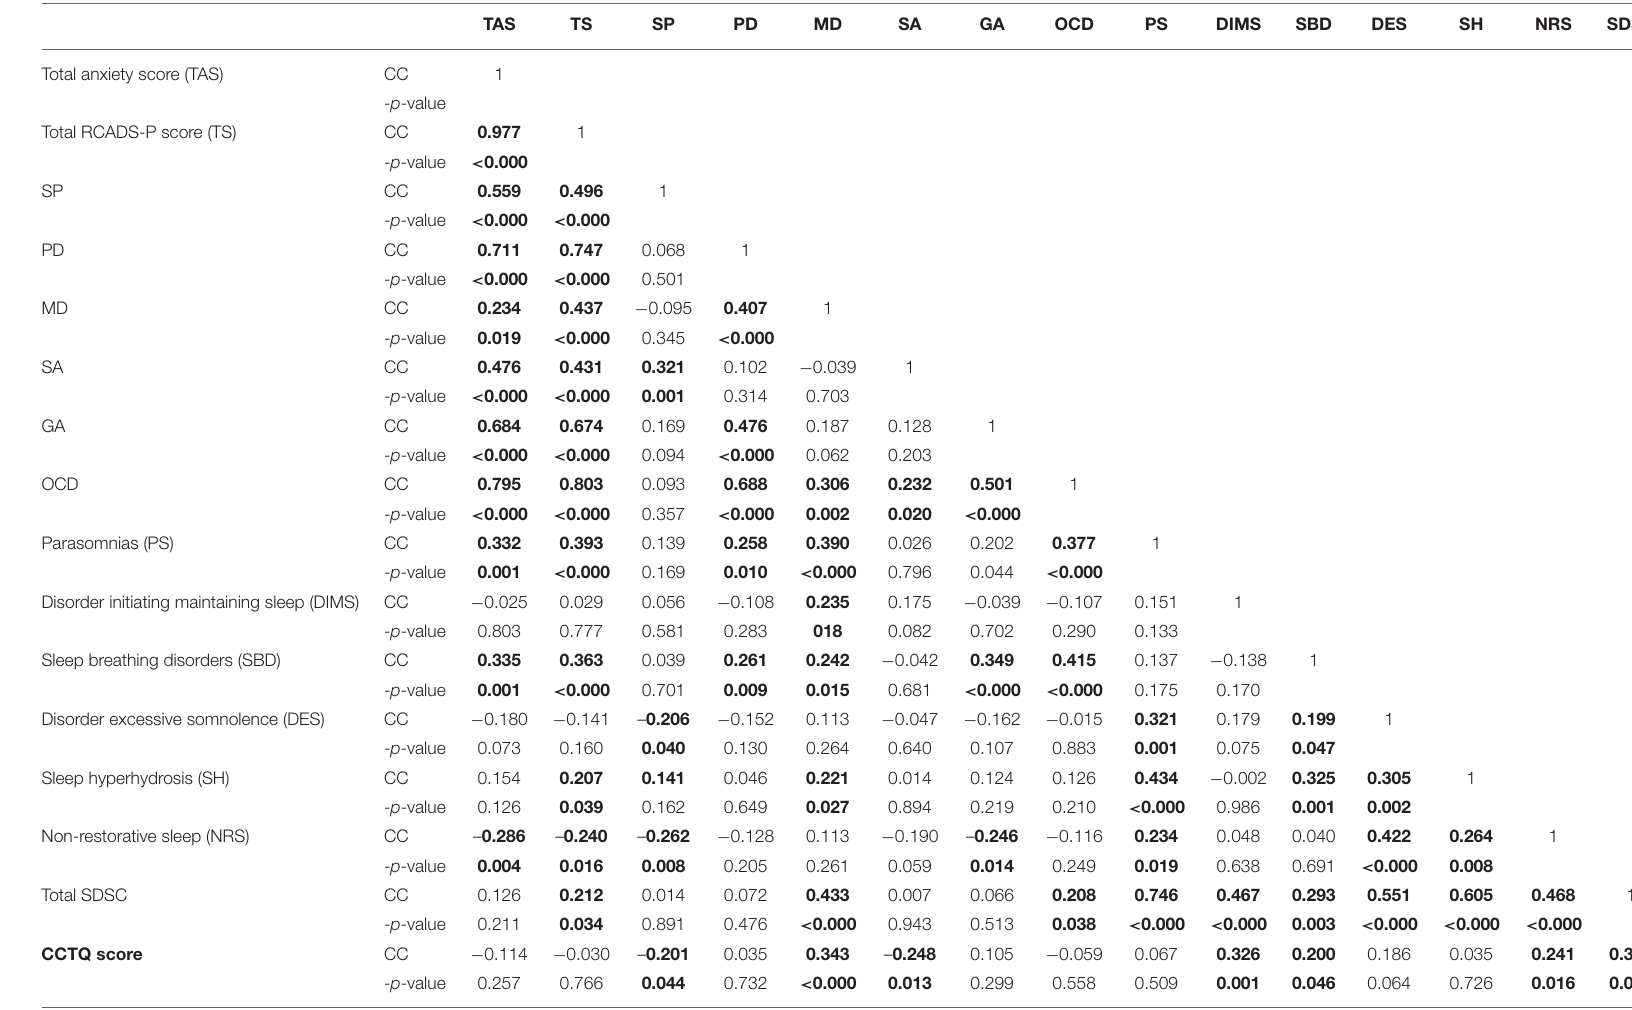
TABLE 4 | Correlations between SDSC, CCTQ, and RCADS-P scores ( N =